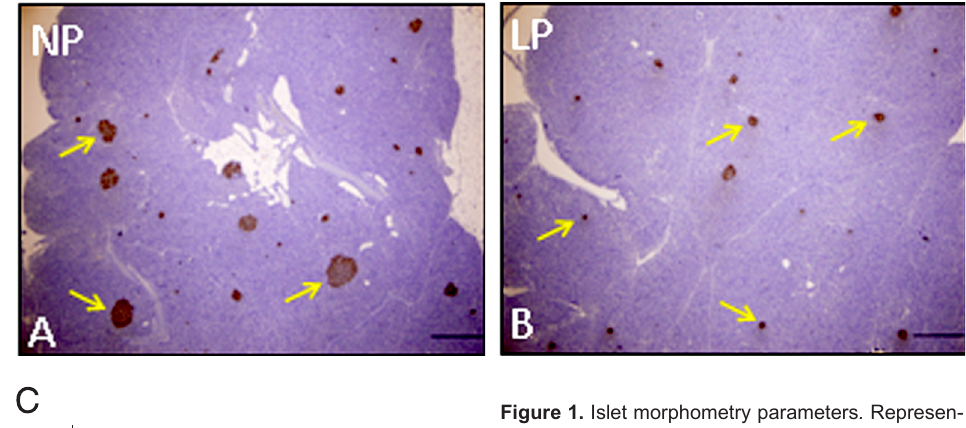
Figure 1. Islet morphometry parameters . Represen- tative images of a pancreas section stained for in- sulin and hematoxylin showing the pattern of islets distribution (A,B). Scale bars = 500 µm. Observe that islets from low-protein diet (LP) rats seem to be smaller in size compared to those observed in nor- mal-protein diet (NP) rats (compare islets indicated by arrows in Figure 1A and B). Absolute β-cell mass (pancreatic weight multiplied by relative β-cell mass) was significantly reduced in rats receiving an LP diet (C). Data are reported as means ± SEM. * P < 0.05 compared to NP (N = 4; Student t-